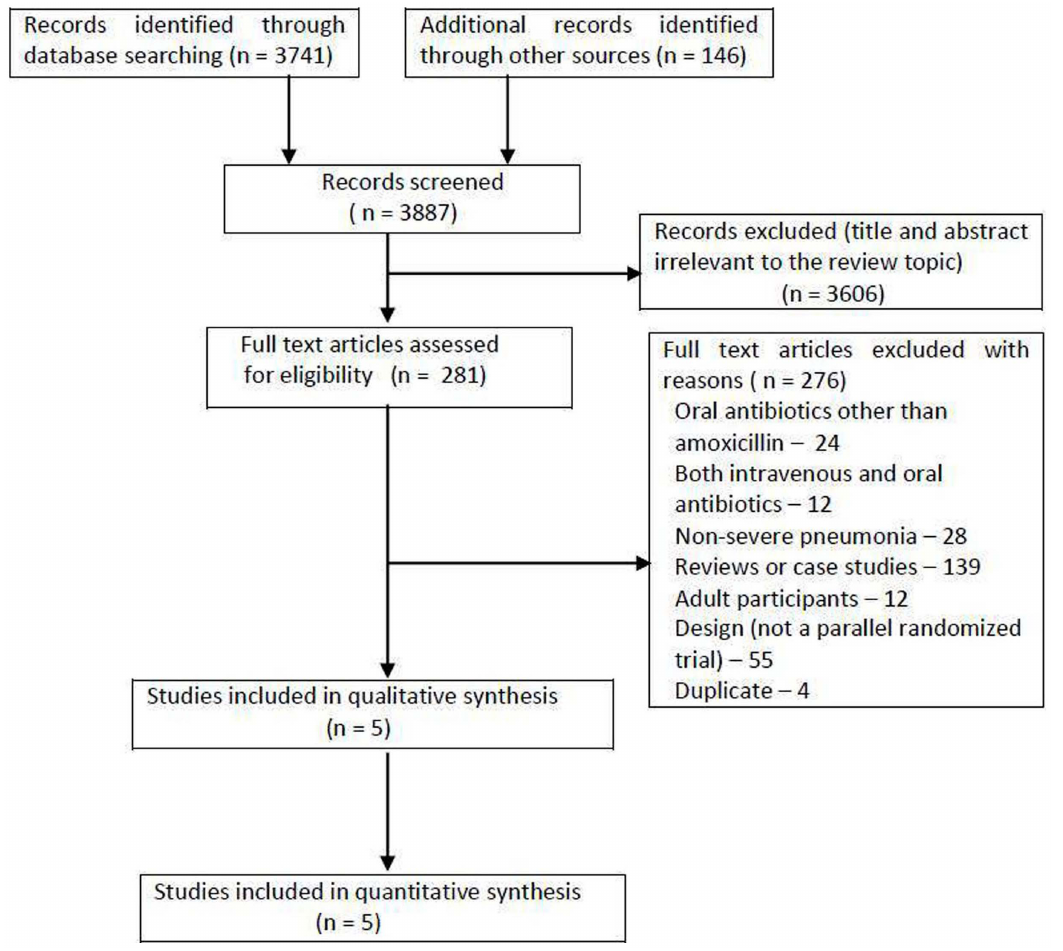
Figure 1. Flow diagram of search results.